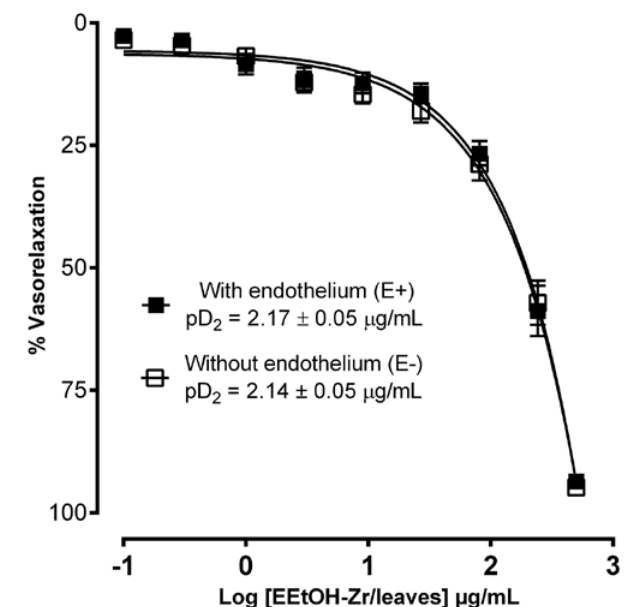
FIGURE 2 - Concentration-response curves of the vasorelaxant effect of EEtOH-Zr/leaves on upper mesenteric artery rings isolated from normotensive mice in the E+(■) and non-E (□) vascular endothelium rats. Values were expressed as mean ± SEM of 5 experiments.